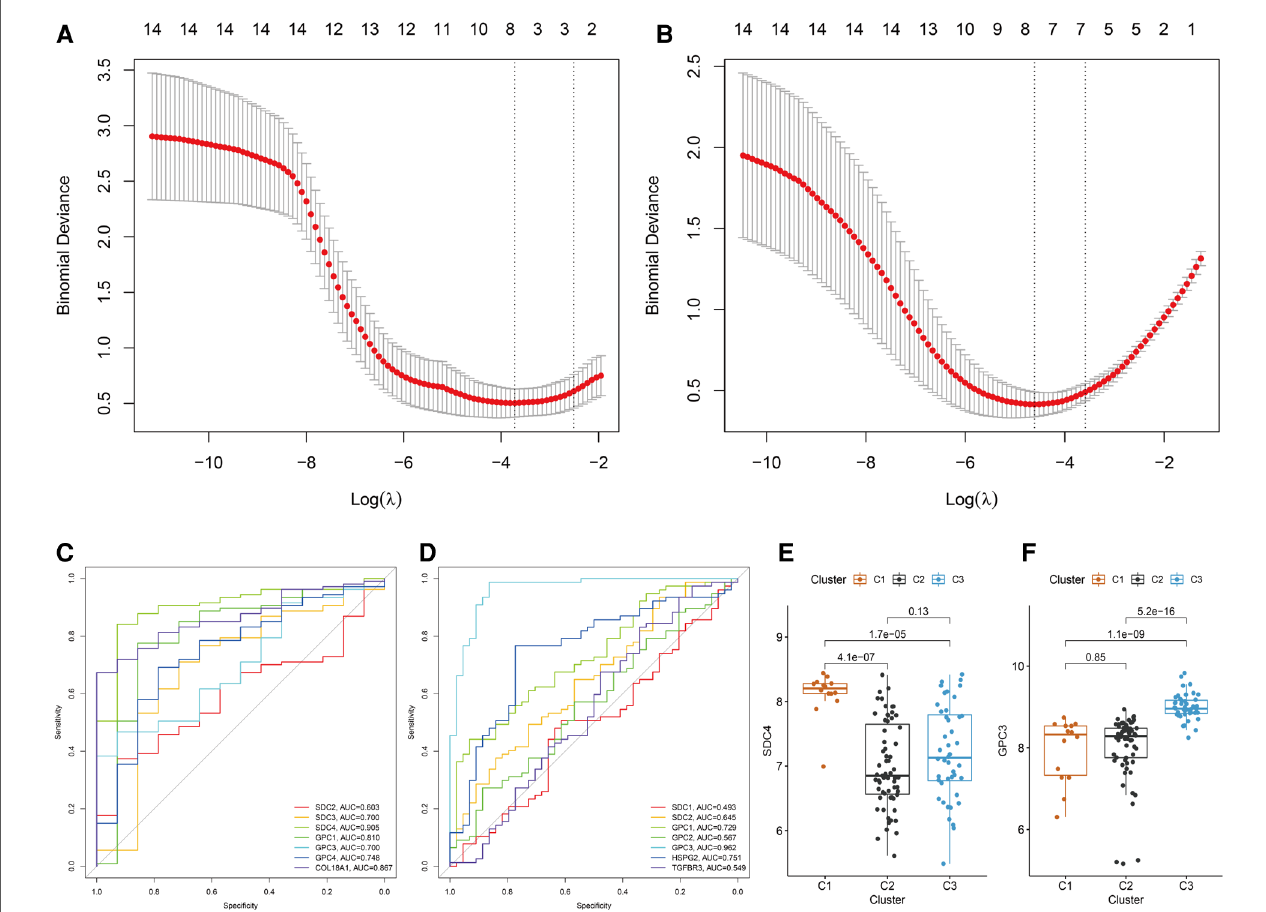
FIGURE 5 Screening hub HSPGs in C1 subtype and C3 subtype. LASSO regression of screening HSPGs in ( A ) C1 subtype and ( B ) C3 subtype. ROC curve of selected HSPGs in ( C ) C1 subtype and ( D ) C3 subtype. ( E ) The expression levels of SDC4 in 3 subtypes. ( F ) The expression levels of GPC3 in 3 subtypes. HSPG, heparan sulfate proteoglycan; LASSO, least absolute shrinkage and selection operator; ROC, receiver operating